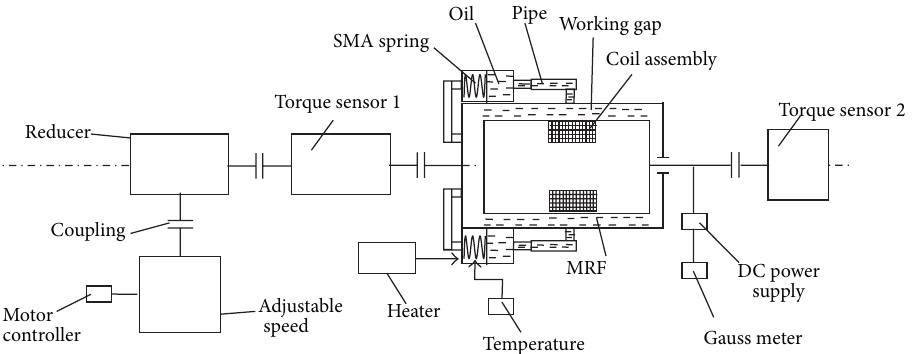
Figure 4: The overall sketch of performance experimental system for cylindrical-type MR fluid transmission driven by shape memory alloy.